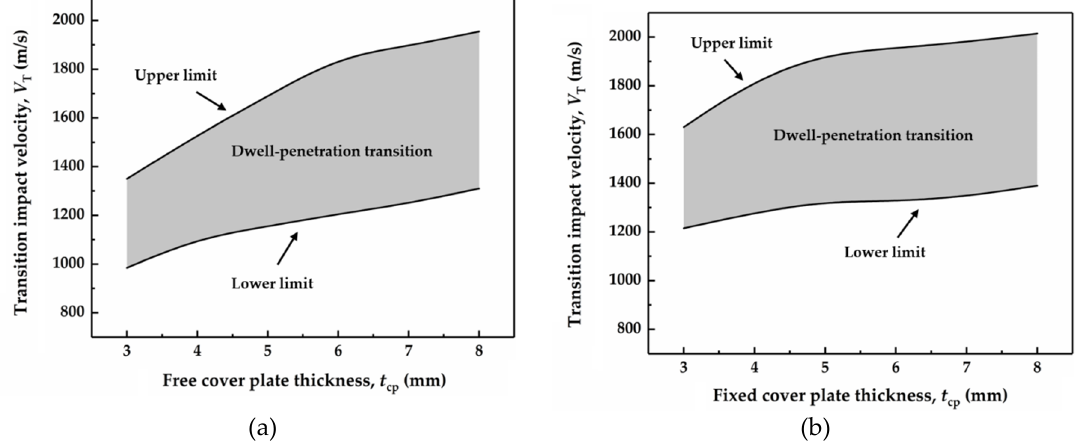
Figure 11. Transition impact velocity versus cover plate thickness. The grey areas correspond to the interval between the lower and upper limits of transition impact velocity. ( a ) Free cover plate and ( b ) fixed cover plate.